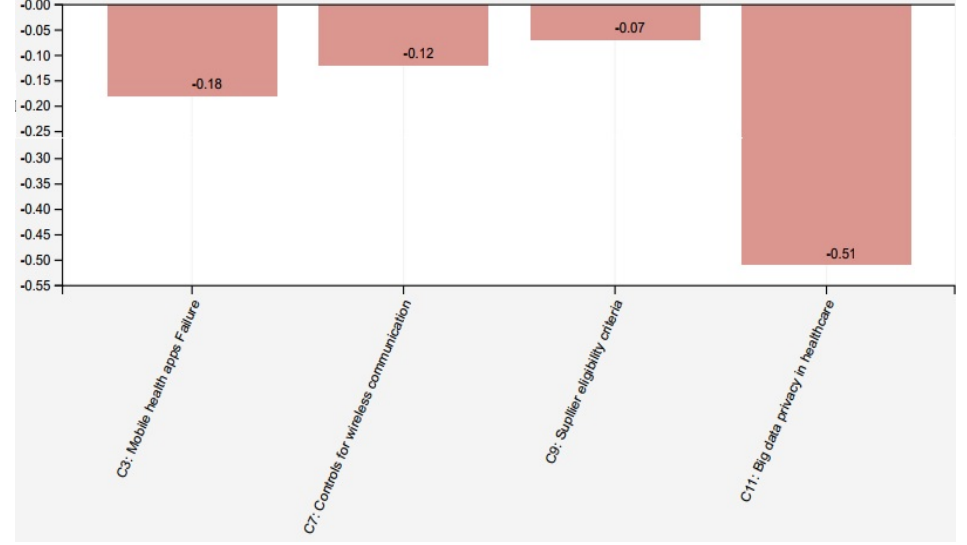
Figure 3. Scenario I: analysis cybersecurity in telehealth .